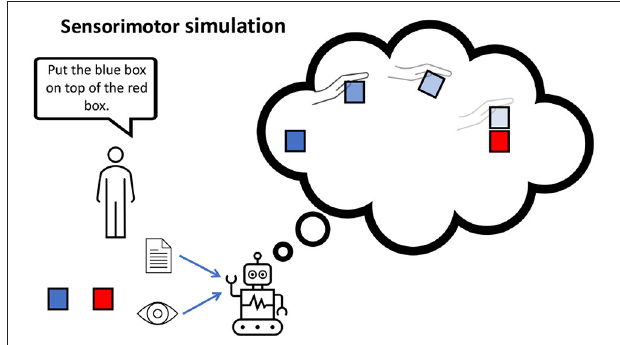
FIGURE 5 | Internal models are capable of mentally simulating possible action trajectories given the visual observation and instruction of stacking the blocks. The longer the simulation horizon, the more uncertain the agent is about its predicted action-effects (illustrated with increasing color